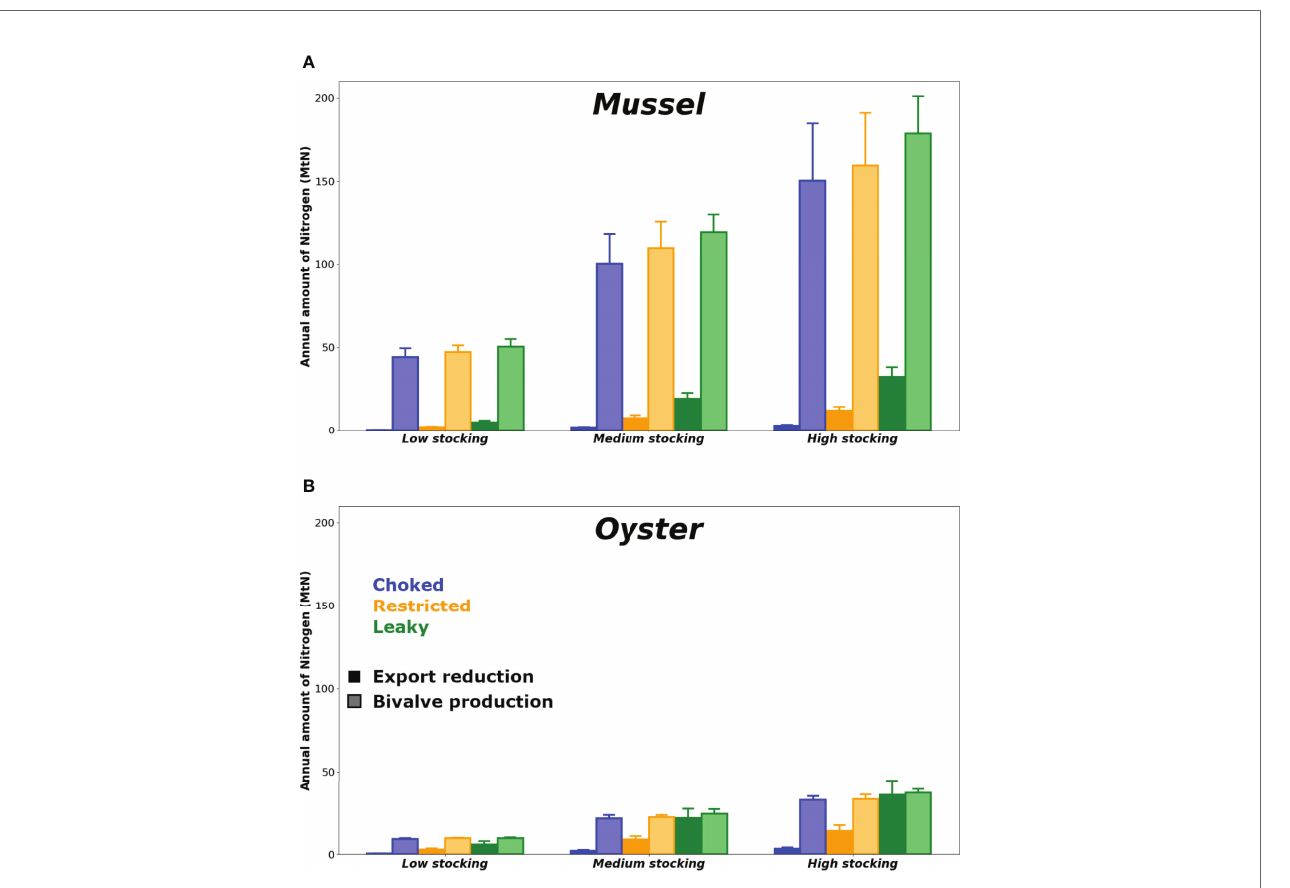
FIGURE 5 | Mean (±SD) nitrogen export reduction (i.e. retention within the bay) and bivalve production (potential nitrogen removal) for (A) mussel and (B) oyster farming the different shell fi sh species, and for the different stocking surface areas and bay morphologies tested. Error bars represent variability introduced by other factors (i.e. nutrient loading and